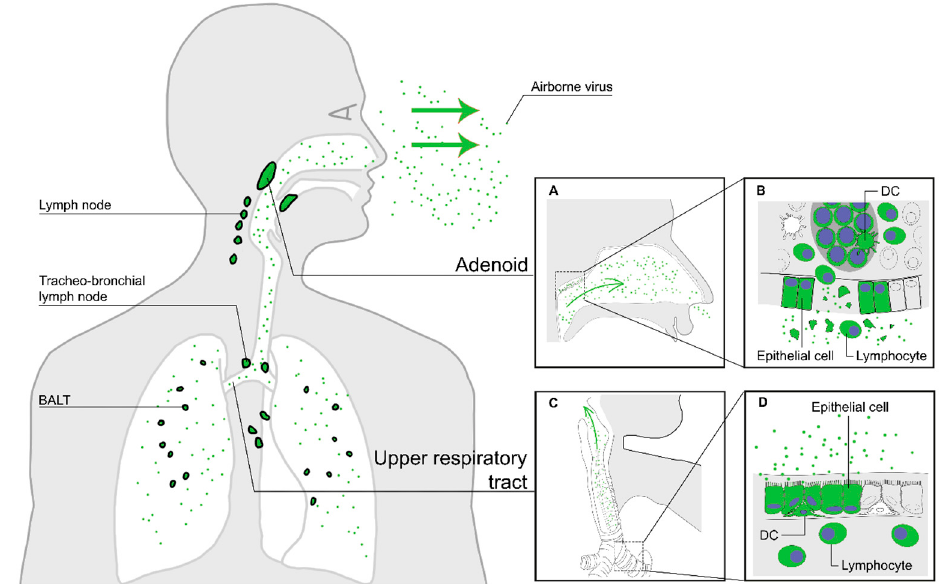
Figure 3. The third stage of MV infection: transmission of new MV particles via the air. Nectin-4 + epithelial cells in the upper and lower respiratory tract epithelium produce new virus particles and release them into the mucus lining the lumen of the respiratory tract (green arrows in panels ( A ) and ( C )). Epithelial damage in infected lymphoid tissues, such as the tonsils ( A ), releases virus particles produced by lymphocytes into the upper respiratory tract ( B ). Epithelial damage in the lower respiratory tract induces cough (panels ( C ) and ( D )), enhancing the discharge of aerosols containing MV particles.